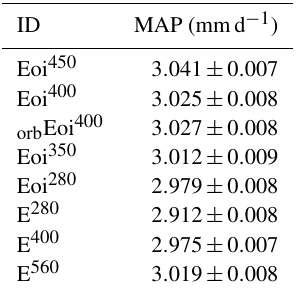
Table 4. Globally integrated mean annual precipitation